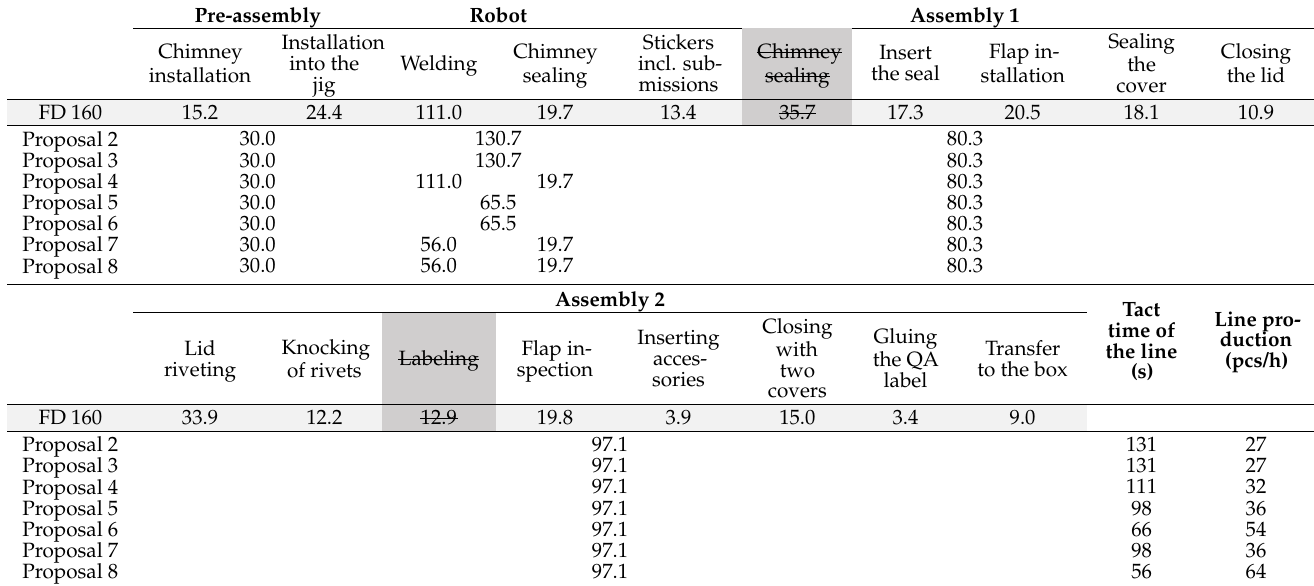
Table 8. Operations times in seconds according to automated production line layout